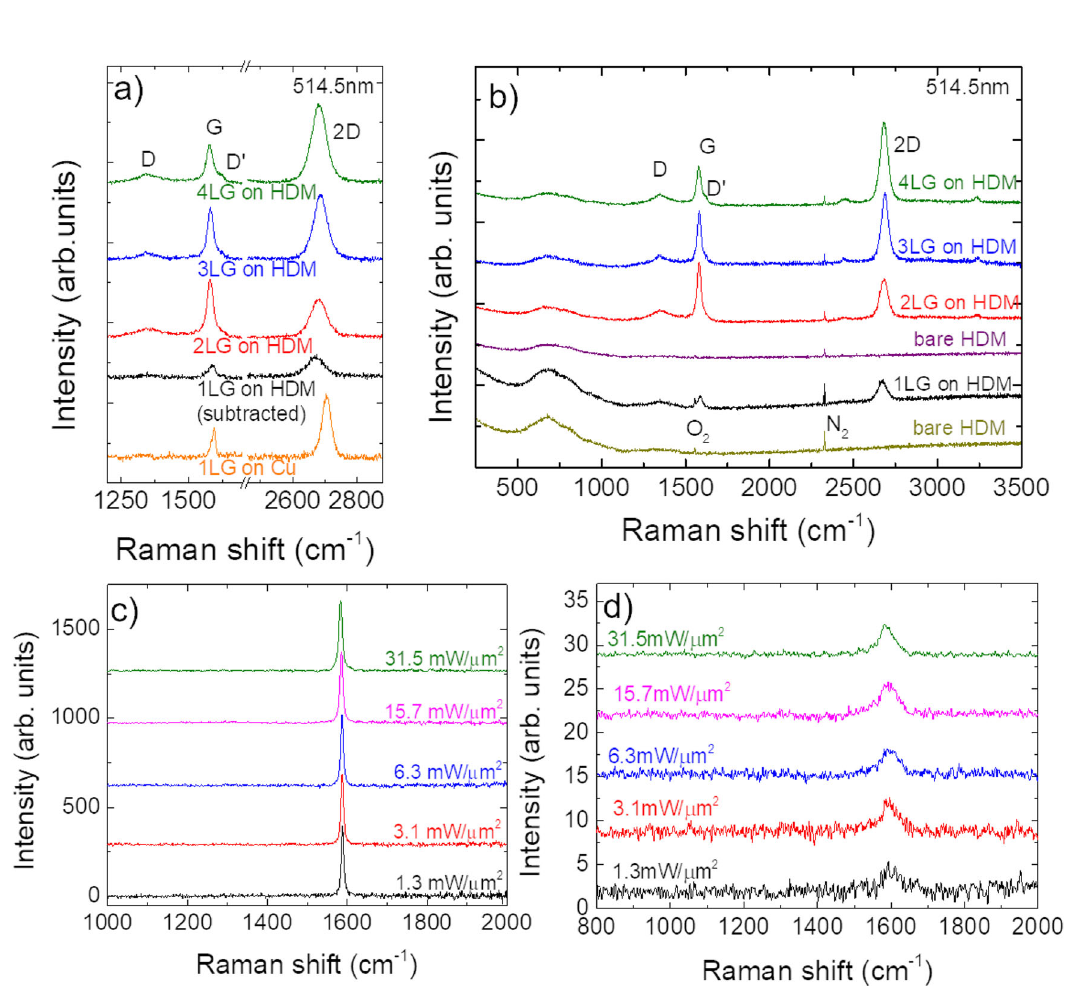
Fig. 2 Raman and irradiation measurements. a 514.5 nm Raman spectra of as-grown 1LG on Cu (before transfer) and 1 – 4LG transferred on CoCrPt:Oxide after CoCrPt:Oxide background subtraction. b 514.5 nm Raman spectra of CoCrPt:Oxide substrates and 1 – 4LG transferred onto CoCrPt:Oxide. c , d 785 nm Raman spectra of 1LG on ( c ) Si/SiO 2 and ( d ) FePt-based HAMR-HDM, for different laser power